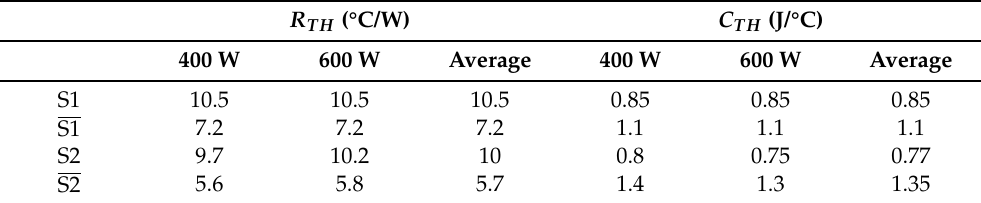
Table 2. Thermal coefficients calculated [11].